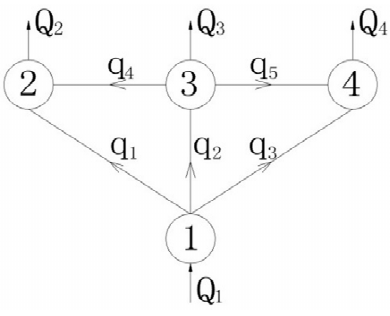
Figure 1. Gas pipeline.